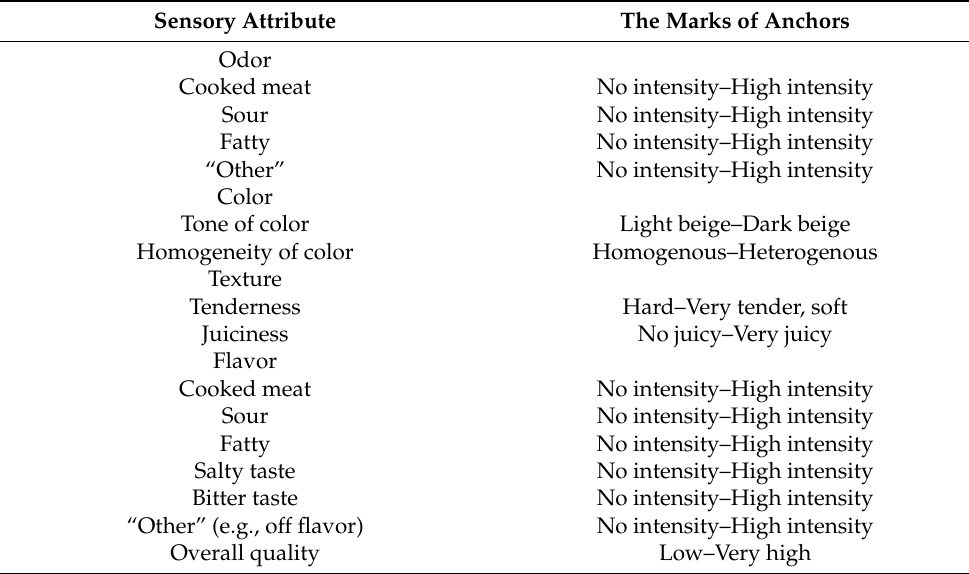
Table 1. Sensory attributes of the quality of chicken breast meat. Sensory